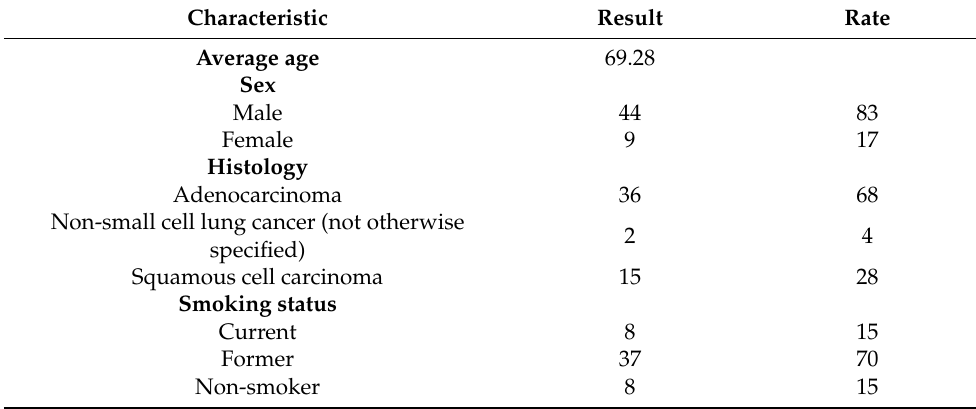
Figure 1. Schematic outline of the study. RNA sequencing data of NSCLC patients with GSE103584 were analyzed by the WGCNA method, and modules with high significant correlation with distant recurrence were identified. The hub genes were intersected for PPI network construction, enrichment analysis, and AUC calculation. The hub genes and image texture features were identified using the Pearson correlation method. The 6 genes and 4 image texture features were significantly correlated. A random forest model of NSCLC distant recurrence was constructed with identified hub genes and image texture features. Table 1. List of clinical data for NSCLC patients. The patient age, sex, type of cancer, smoking status, epidermal growth factor receptor (EGFR) mutation, Kirsten rat sarcoma virus (KRAS) mutation, and cancer progression are